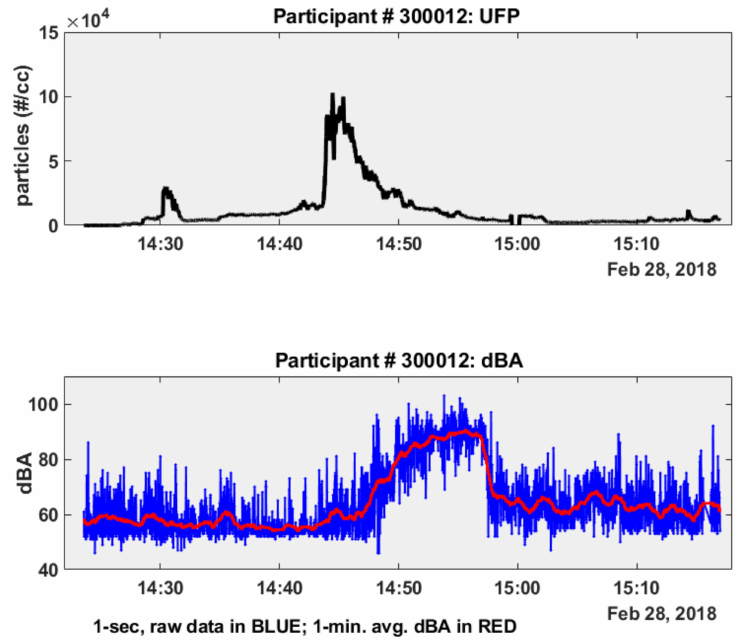
Figure 4. Time-series subplots of PNC (#/cc) and Noise (dBA), participant # 300012—28 February 2018.